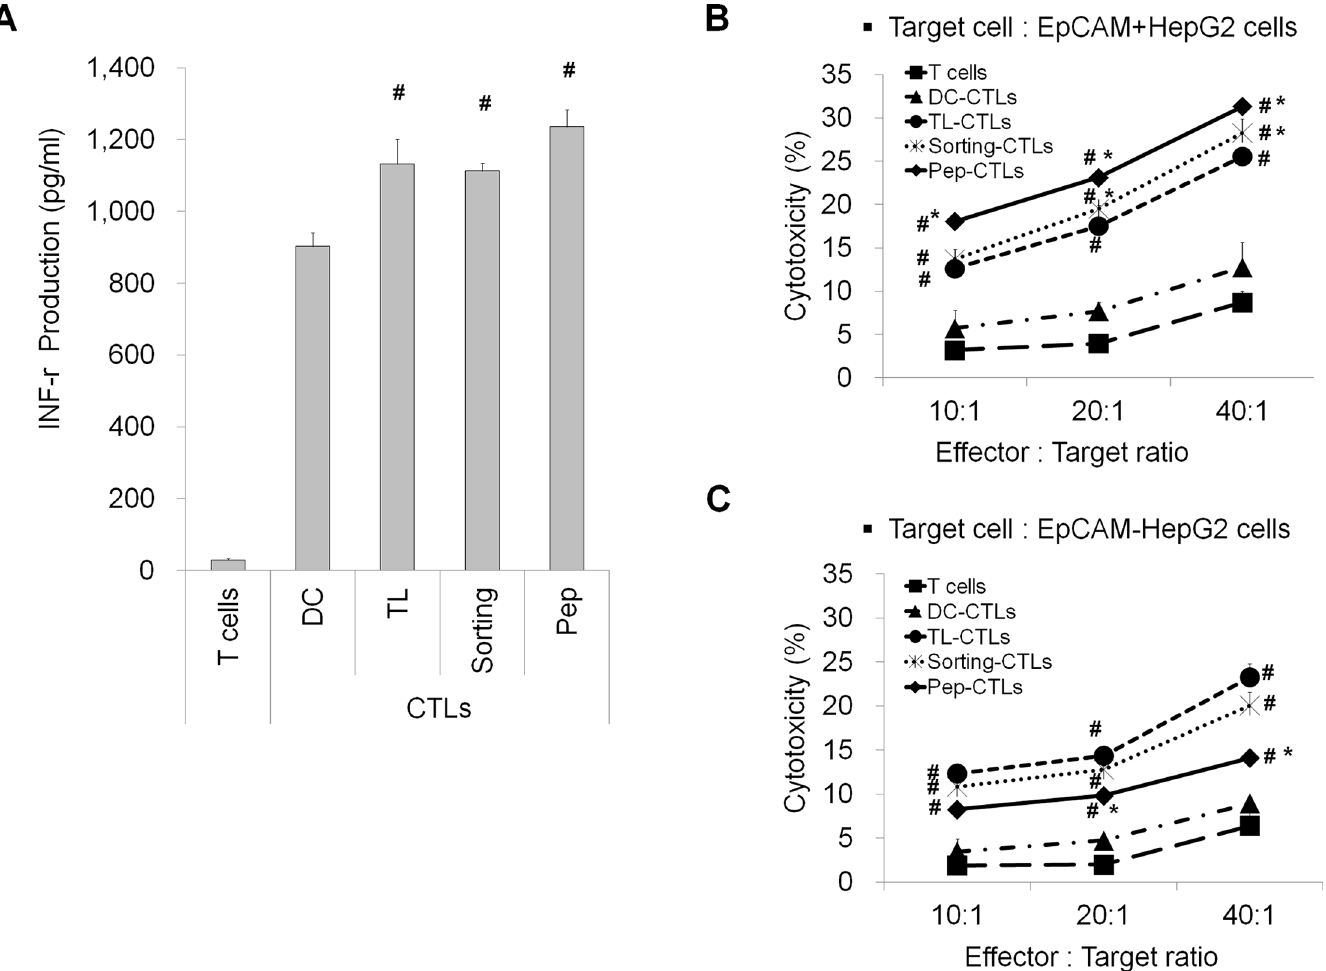
Fig 4. Characterization of the EpCAM peptide-specific CTL responses against HepG2 CSCs. (A) IFN- γ release by antigen-specific CTLs stimulated by antigens. Na ï veT cells stimulatedby co-culturing with tumor antigen-pulsed DCs were analyzedby ELISA for their productionof IFN- γ . (B and C) Results from a cytotoxicity assay of CD8 + T cells activated by tumor antigen-pulsed DCs. Different DCs were co-culturedat a ratio of 1:5 with lymphocytes for 5 days. The non-adherent cells were collectedand countedas effector cells. The effector cells were co-cultured with the EpCAM positive (B) and EpCAM negative(C) HepG2 cells at different ratios for 6 h at 37˚C in a 5% CO 2 incubator. The data are expressedas the mean ± SD,and significant differences betweenthe treated groupswere detected using ANOVA followedby the Dunnett’s test. # p < 0.05comparedwith the DCs or DC-CTLs, and * p < 0.05comparedwith the